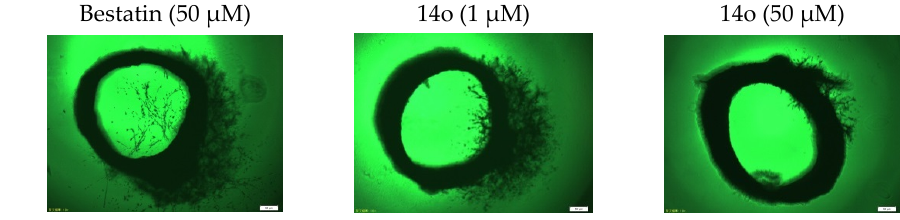
Figure 3 . Representative images of the rat thoracic aorta rings treated with DMSO (0.5%) or com-